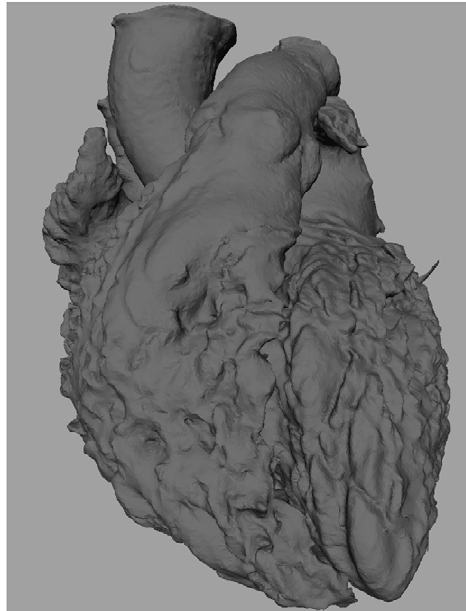
Figure. 1 Latex cast of a human heart.